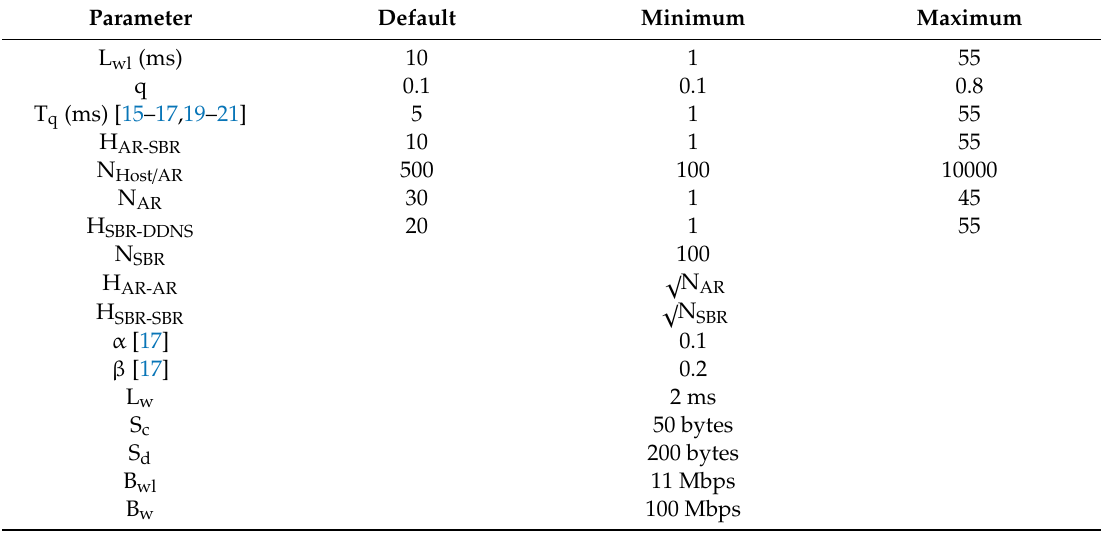
Table 5. Default parameter